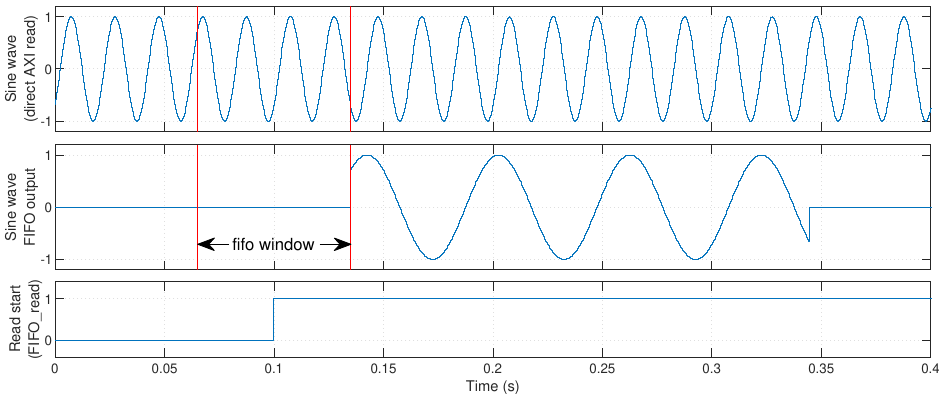
Figure 14. Sine wave full-sampled acquisition using a FIFO window of 1000 samples, starting 500 samples before the trigger